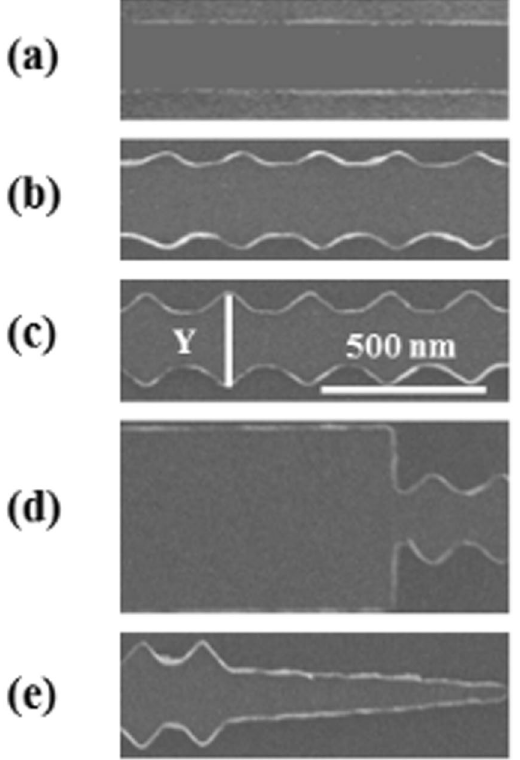
Figure 1. Scanning Electron Microscopy (SEM) images of nanowires with different geometries produced to study DW propagation in bilayer NiFe/Pt films. Periodic modulation placed on the nanowire edges provides pinning potential to the DW propagation. Also, pad injection and tapered shape were used to inject and annihilate DWs,